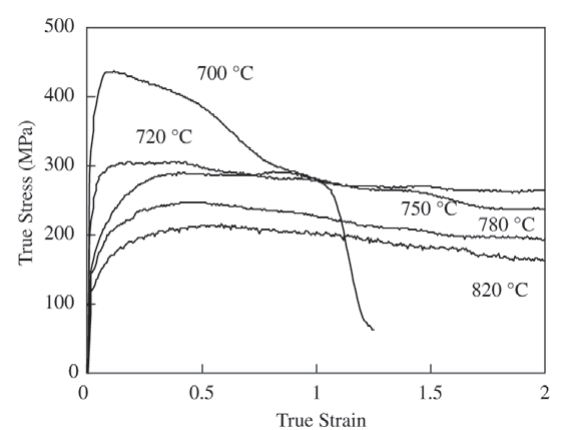
Figure 3. Continuous isothermal flow stress curves for 1 min (700 °C) and 3 min (720, 750, 780 and 820 °C) holding time.